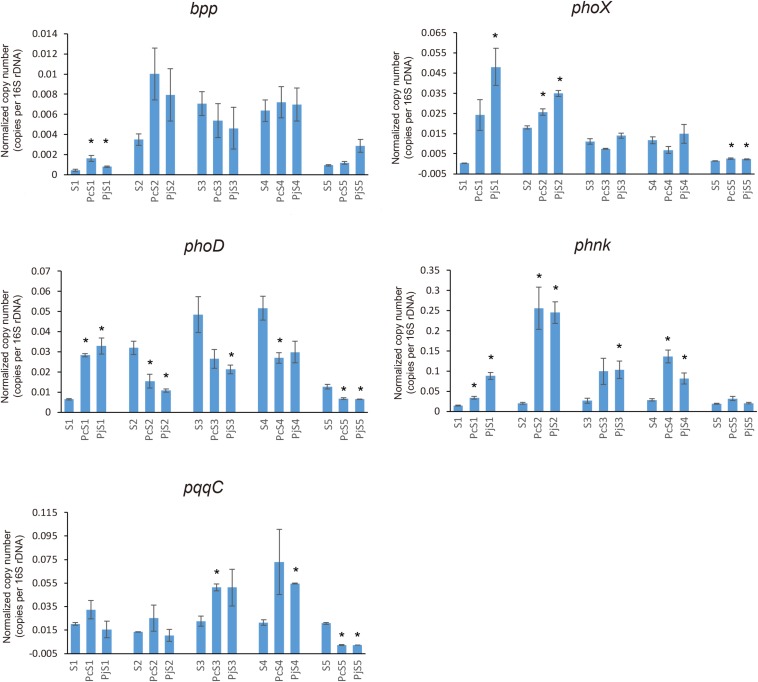
Distribution and relative abundance of phosphorus-cycling genes in soil and hyphae-associated communities. The relative abundance of genes was calculated by the ratio of absolute copy numbers of target genes to 16S rRNA genes in each sample. All data were presented as the mean ± standard error of three replicates. Significant differences in relative abundance of P-cycling genes between soil and hyphae-associated samples were analyzed in each microcosm and are indicated by stars (Student’s t-test, P < 0.05).